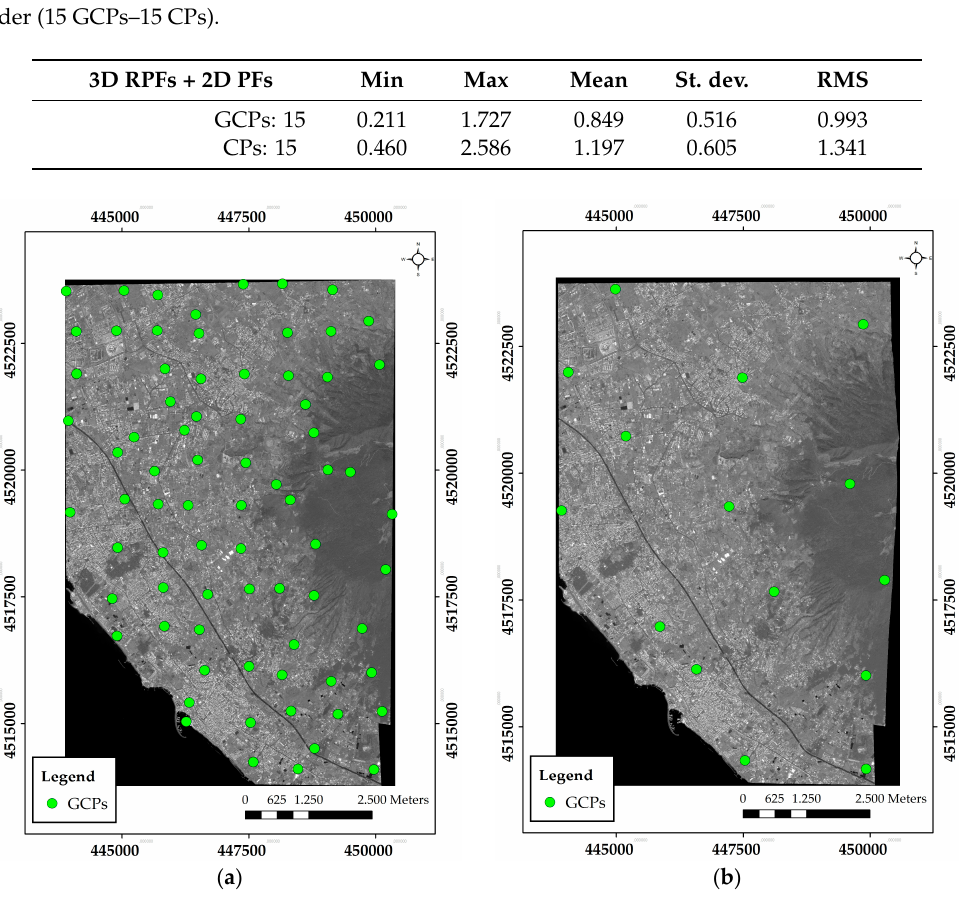
Figure 6. The combination of 3D RPFs and 2D polynomial functions (PFs): ( a ) 75 GCPs used for 3D RPFs without RPCs; ( b ) 15 GCPs used for 2D PFs first order. The coordinates reported are referred to as UTM/WGS84 (33 N—zone T) and expressed are in meters.